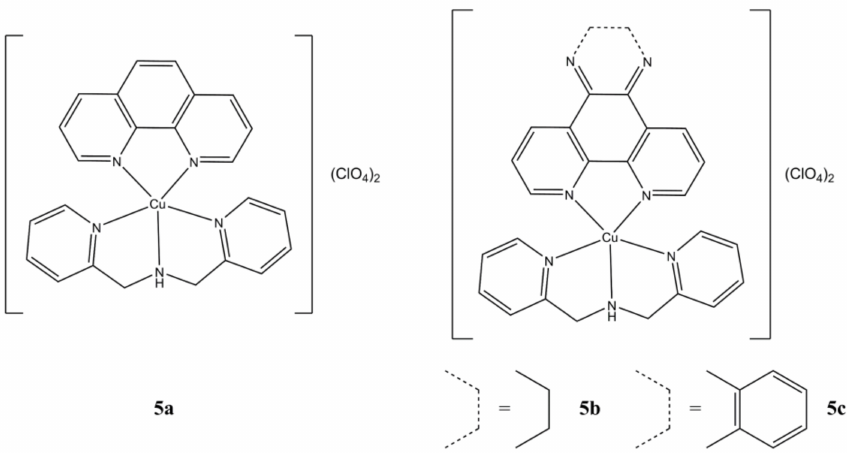
Figure 5. Structures of the [Cu(N-N 2 )(DPA)](ClO 4 ) 2